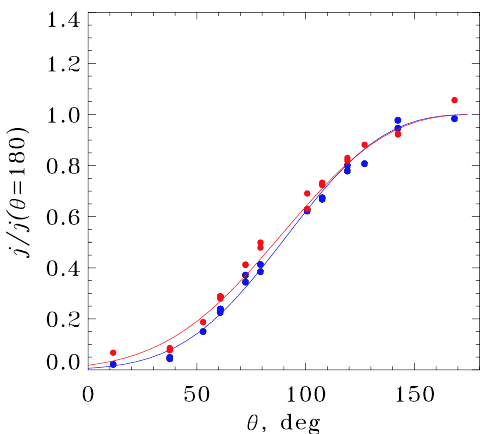
Current angular distribution in an O + plasma with V 0 = 4 V Ti , λ D = r s = 2cm, T = 0 . 1 eV ,ϕ =− 40 kT/e . Red and blue lines stand for the results of the model with the cell size of λ D / 2 and λ D , respectively. Currents are normalized to their values for θ =180 ◦